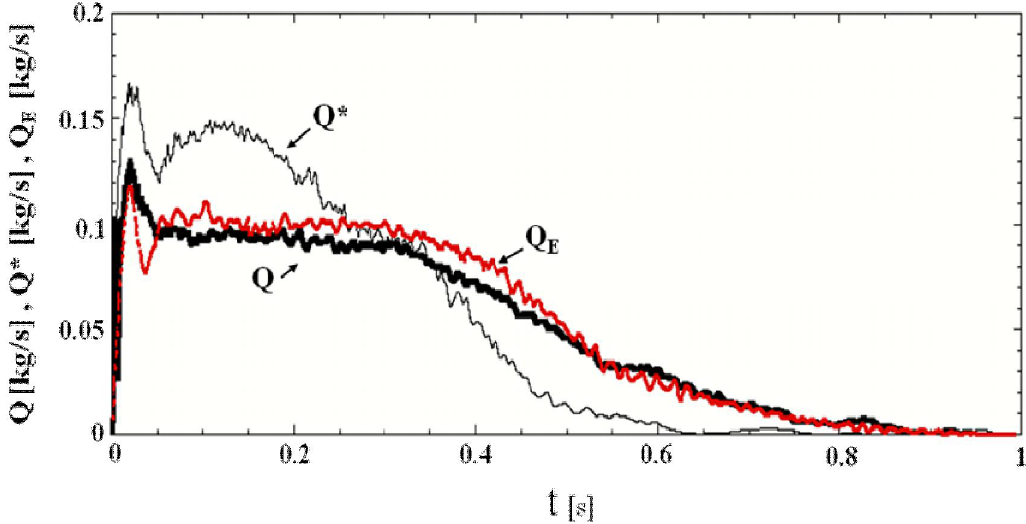
Figure 6. Evolution of granular flow rates from the hopper outlet, where Q, and Q * are the calculated granular flow rates in the presence of air and in a vacuum, respectively, and Q is the experimental granular flow rate in the presence of air.